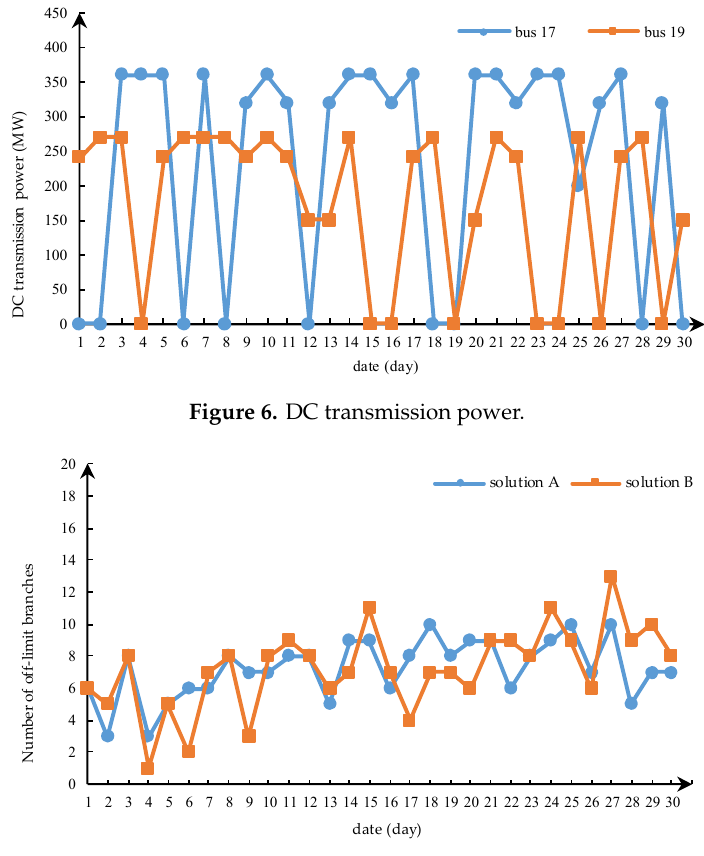
Figure 7. Branch o ff -limit power flow during the maintenance Figure 7. Branch off-limit power flow during the maintenance period. Figure 7. Branch off-limit power flow during the maintenance period.